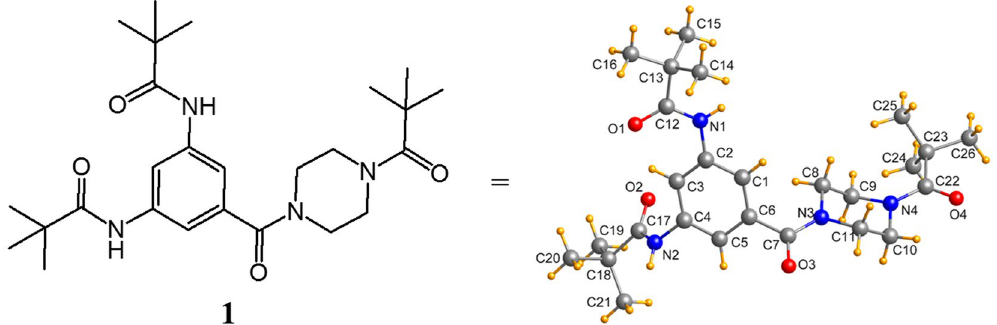
Figure 5. The molecular structure and conformation of 1 in the studied crystal.